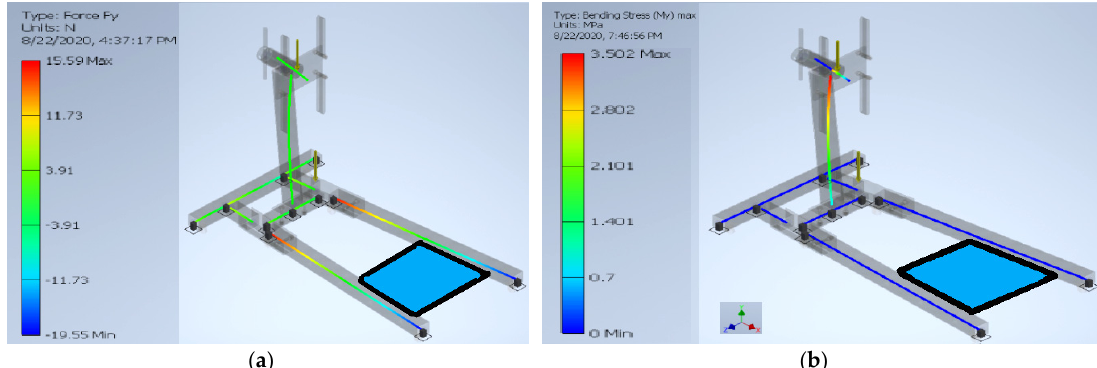
Figure 10. Robotic arm in displacement analysis stage: ( a ) critical area; ( b ) second-level displacement.